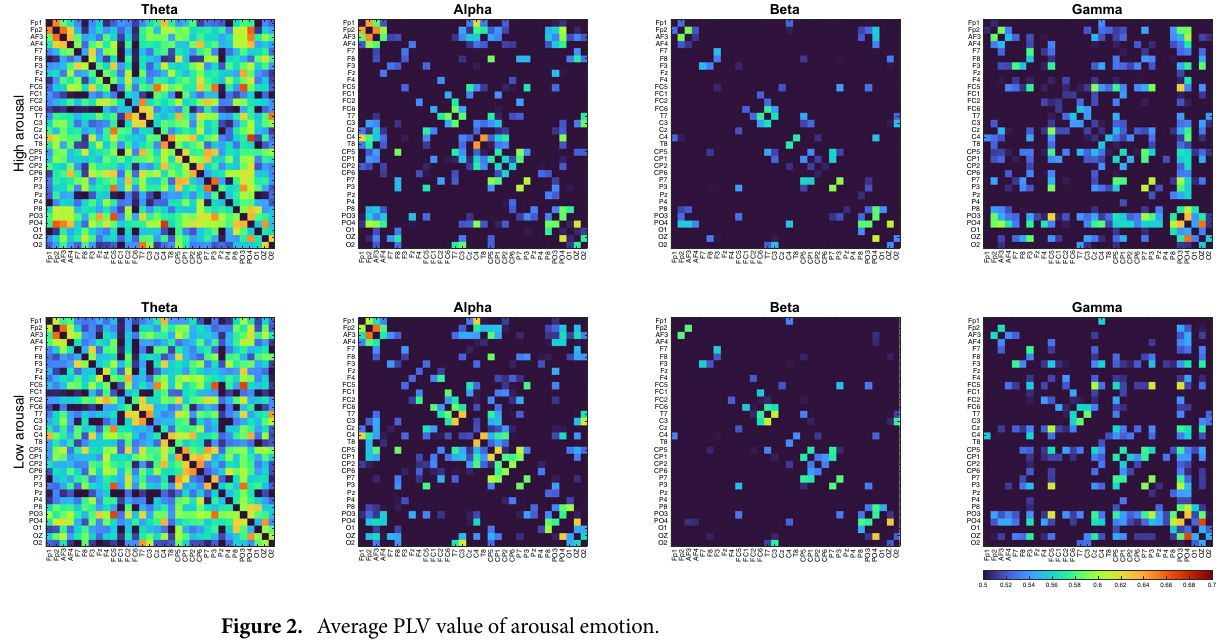
Figure 2. Average PLV value of arousal emotion.